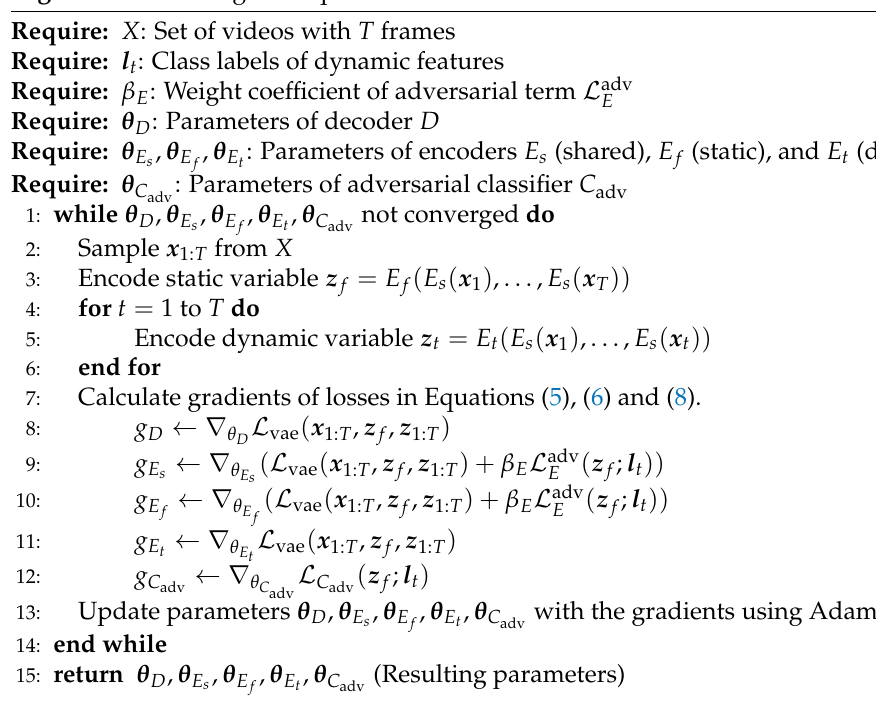
Algorithm 1 Training for sequential VAE with adversarial